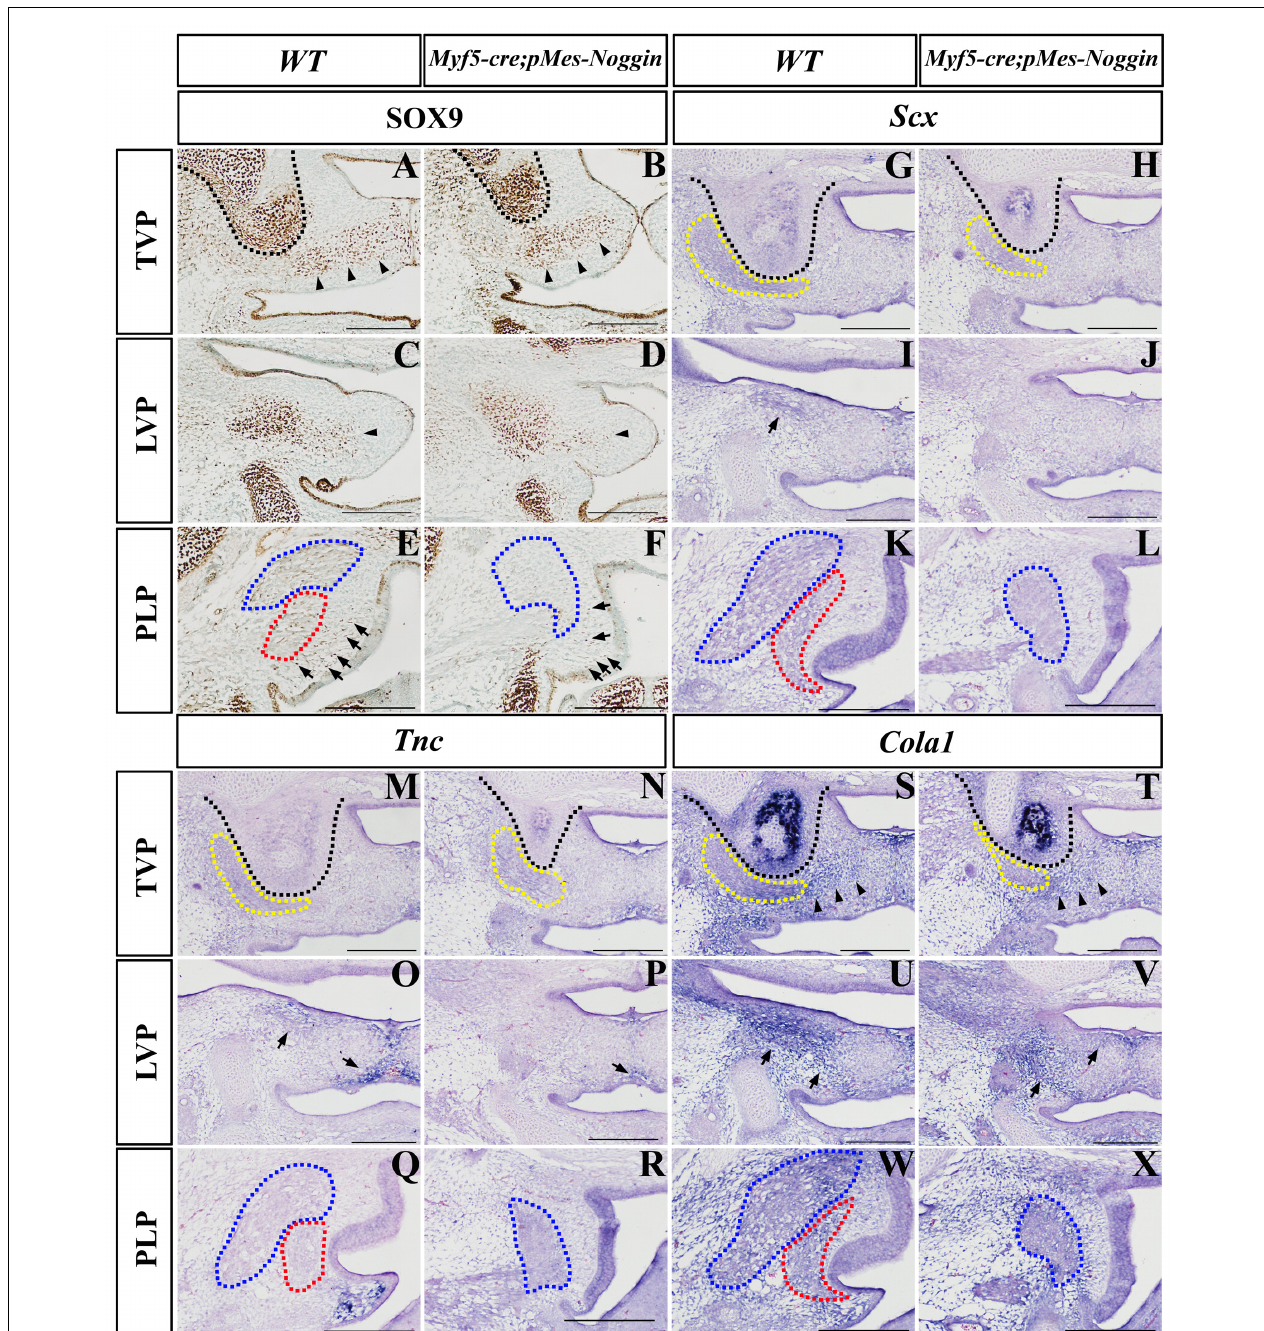
FIGURE 6 | The Sox9, Scx , TnC , and Col1a1 expression in Myf5-cre;pMes-Noggin soft palates. (A–F) The Sox9 immunostaining in the E14.5 WT soft palate at the TVP (A) , LVP (C) , and PLP (E) levels, and the E14.5 Myf5-cre;pMes-Noggin soft palate at the TVP (B) , LVP (D) , and PLP (F) levels. The arrowheads in (A–D) point to the Sox9 domain in the mesenchyme. The arrows in (E,F) point to the Sox9-positive cells in the mesenchyme. (G–L) In situ hybridization of Scx in the E14.5 WT soft palate at the TVP (G) , LVP (I) , and PLP (K) levels, and the E14.5 Osr2-cre KI ;pMes-Noggin soft palate at the TVP (H) , LVP (J) , and PLP (L) levels. The arrows in (I) point to the LVP areas. (M–R) In situ hybridization of TnC in the E14.5 WT soft palate at the TVP (M) , LVP (O) , and PLP (Q) levels, and the E14.5 Osr2-cre KI ;pMes-Noggin soft palate at the TVP (N) , LVP (P) , and PLP (R) levels. The arrows in (O,P) point to the TnC -positive area. (S–X) In situ hybridization of Col1a1 in the E14.5 WT soft palate at the TVP (S) , LVP (U) , and PLP (W) levels, and the E14.5 Osr2-cre KI ;pMes-Noggin soft palate at the TVP (T) , LVP (V) , and PLP (X) levels. The arrowheads in (S,T) delineate the Col1a1 -positive areas along the presumptive aponeurosis. The arrows in (U,V) point to the Col1a1 -positive areas. The black dotted lines delineate the HPPs; the yellow dotted lines circle TVPs; the blue dotted lines delineate SPCs; the red dotted lines delineate PLPs. Scale bars are 200 µ m. TVP, tensor veli palatini; LVP, levator veli palatini; PLP, palatopharyngeus; HPP, hypophosphatasia; SPC, superior pharyngeal constrictor.